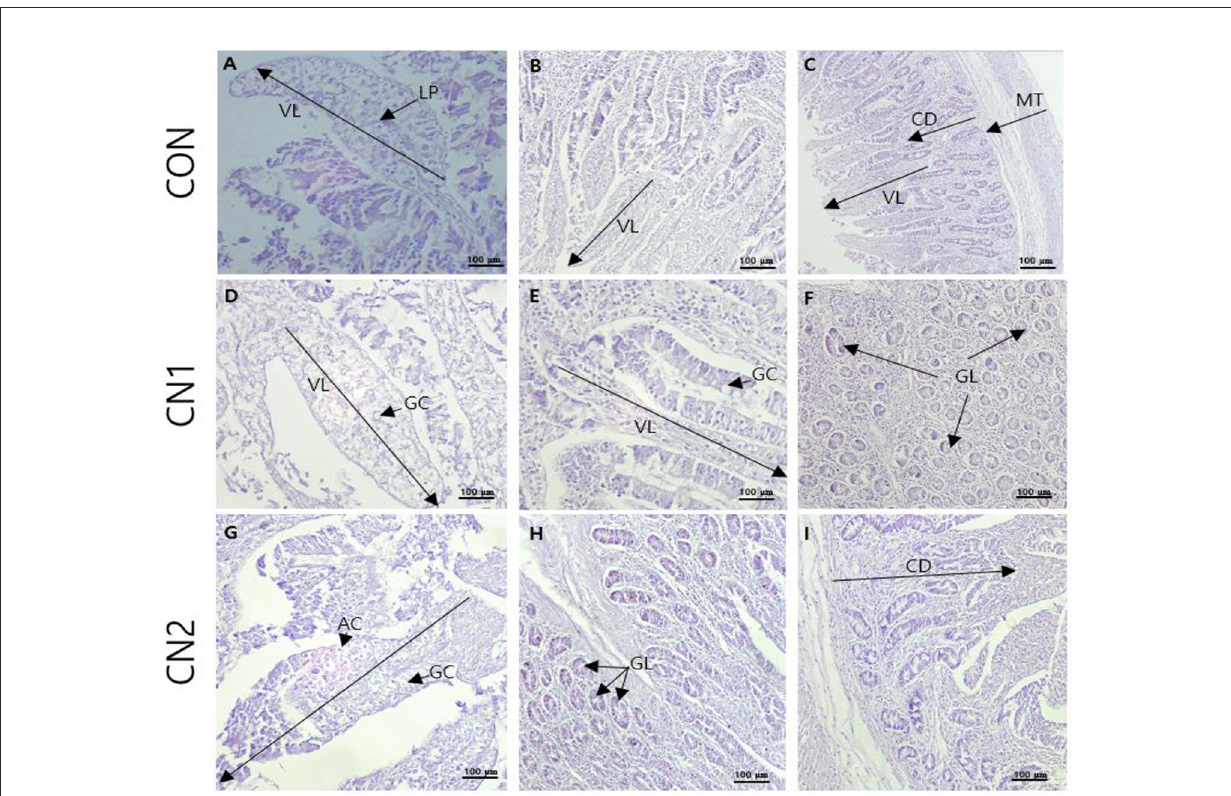
FIGURE1 The representative photomicrographs from the jejunal sections of small intestine ( n = 6) in finishing pigs fed (A–C) the control (CON) diet wihout curcumin nanospheres (CN); (D–F) the control diet supplemented with CN at 1.0 ml/kg diet (CN1); (G–I) the control diet supplemented with CN at